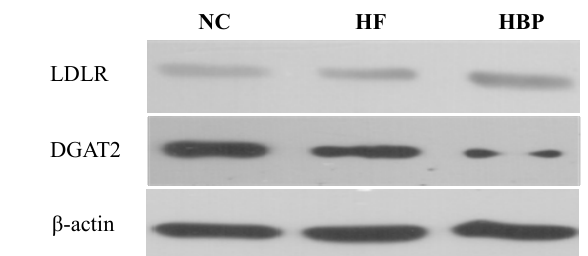
Figure 4. Effects of HBP on the expression of genes related with cholesterol and triglyceride metabolism in the liver: ( A ) Relative mRNA level of LDLR and DGAT2; ( B ) relative protein levels of LDLR and DGAT2; ( C ) representative bands of immunoblot. Values not sharing a letter in common are significantly different, p < 0.05.